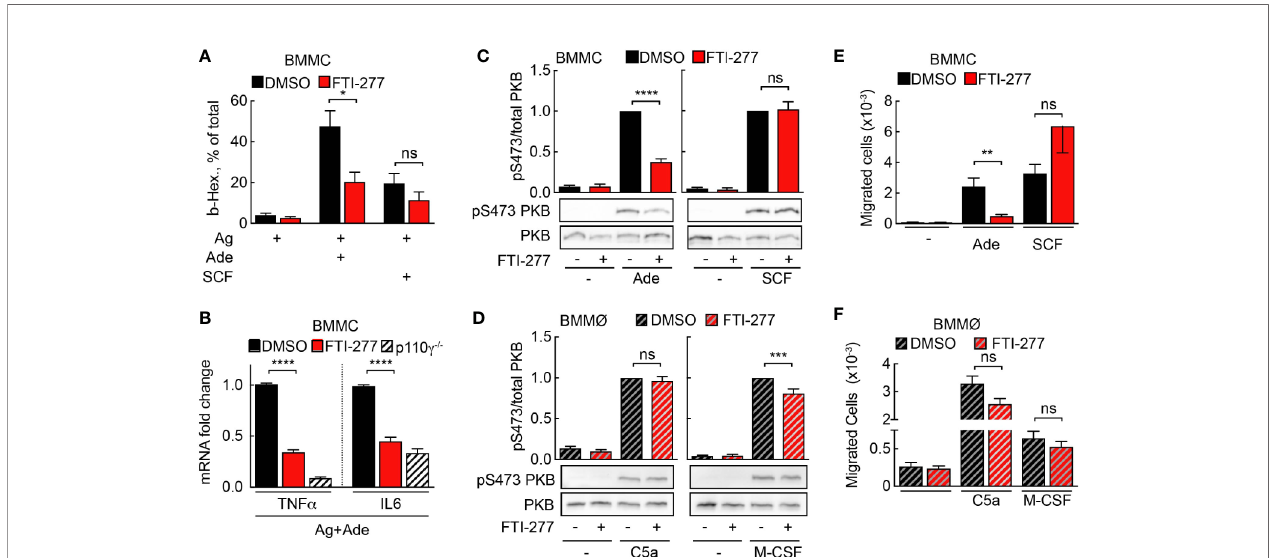
FIGURE 5 | Mast cell but not macrophage activation is affected by FTI-277-mediated Ras inhibition. (A) DMSO- or FTI-277-treated WT-BMMCs were loaded overnight with anti-DNP IgE (100 ng/ml) followed by stimulation with DNP-HSA (Ag, 2 ng/ml) alone or in combination with 2µM Ade or 10 ng/ml SCF. Release of b -Hexosaminidase was quanti fi ed 20 min after stimulation (n = 6 – 7). (B) DMSO- or FTI-277-treated WT-BMMCs as well as p110 g − / − BMMCs were exposed overnight to anti-DNP IgE (100 ng/ml) followed by stimulation with DNP-HSA (Ag, 2 ng/ml) together with 1 µM Ade for 6 h. TNF- a and IL-6 expressions were determined by qPCR and normalized to the level of GAPDH expression. Fold change of expression in FTI-277 treated or p110 g − / − cells was quanti fi ed relative to DMSO-treated control (n = 6). (C, D) BMMCs and BMMØs were treated with either DMSO or 5 µM FTI-277 for 72 h, starved for 4 h, and activated with 2 µM Ade, 10 ng/ml SCF, 10 nM C5a, or 30 ng/ml M-CSF for 2 min at 37°C. Phosphorylation of PKB at Ser473 was determined by Western blot analysis of cell lysates with anti-PKB-Ser473 antibodies and normalized to the total level of PKB (n = 9 – 18). (E, F) Migration of BMMCs and BMMØs was assessed in Transwell chambers for